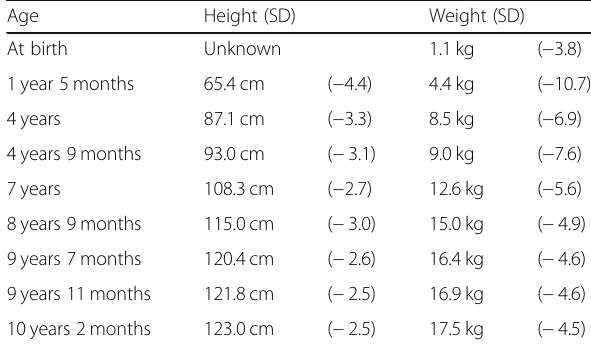
Table 3 Heights, weights and their standard deviations according to